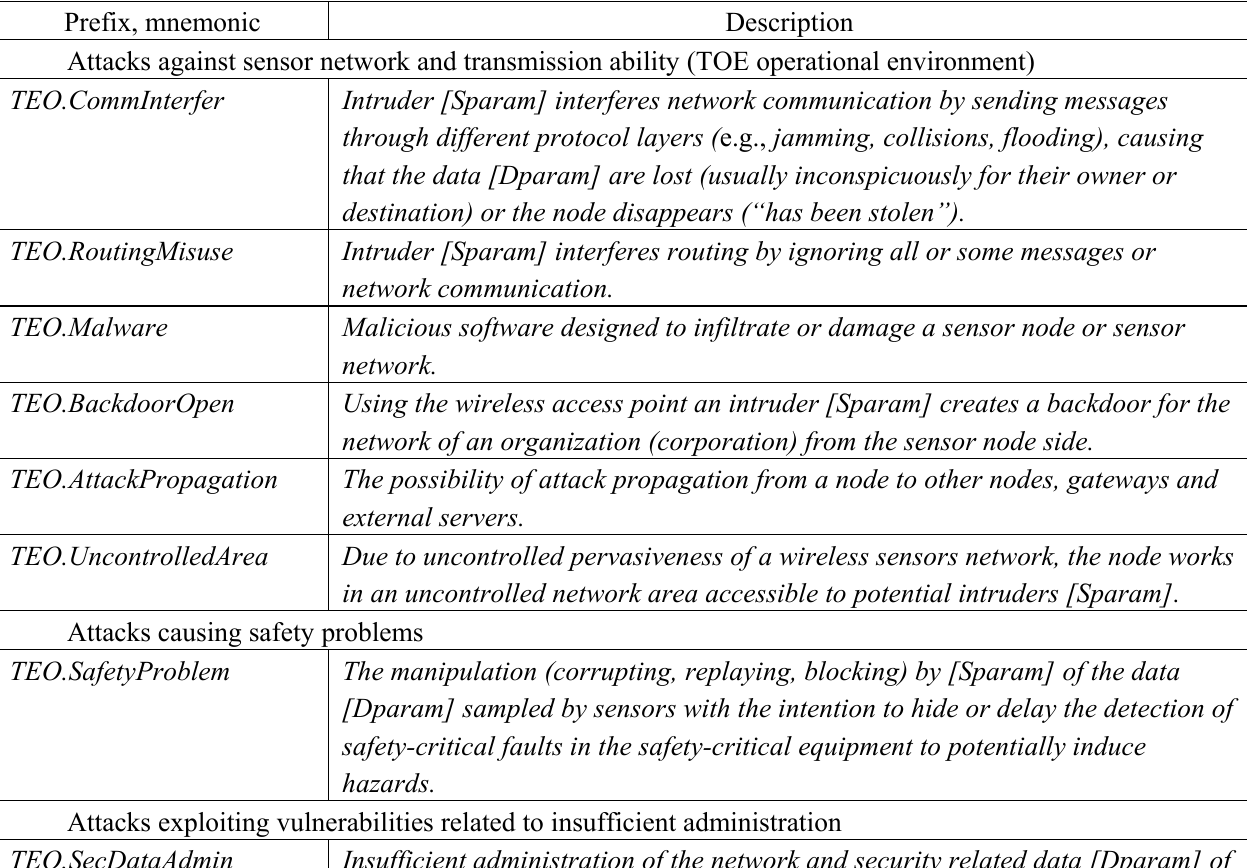
Table 11. Threats related to the TOE operational environment expressed by enhanced generics. Prefix, mnemonic